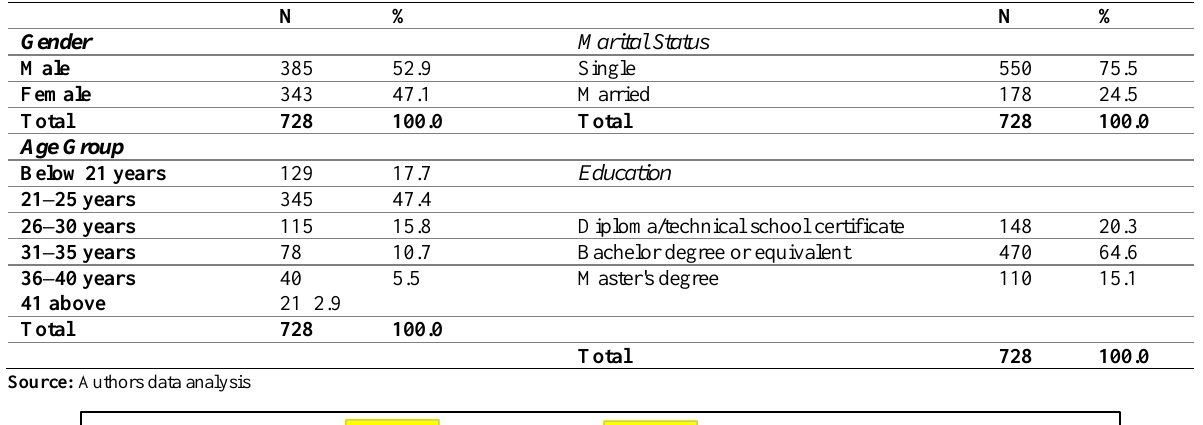
Table 1: Demographic Characteristics